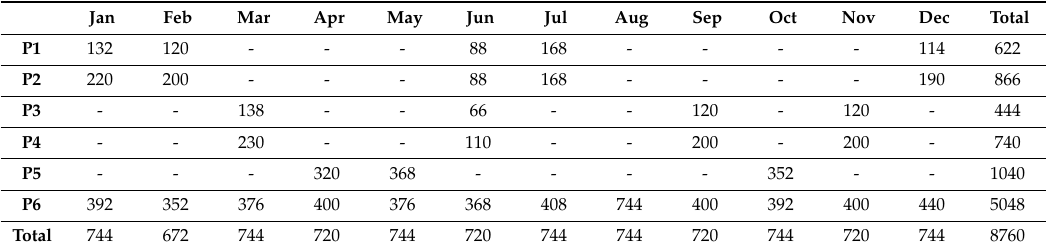
Table 3. Number of hours of the regulated access tari ff of six